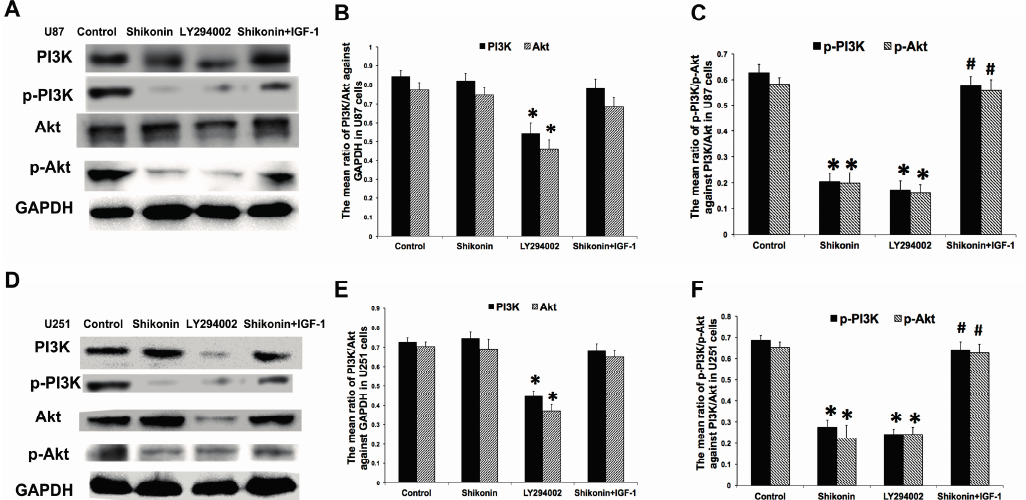
Figure 9. The effects of PI3K/Akt inhibitor or agonist on the expression of p-Akt and p-PI3K in glioma cells. U87 and U251 cell were treated with shikonin (5 μ mol/L), PI3K/Akt inhibitor LY294002 (20 μ mol/L), or shikonin combined with PI3K/Akt agonist IGF-1 (20 μ g/mL). Only LY294002 inhibited the expression of PI3K and Akt in both cell lines compared with the control group. The expression of p-PI3K and p-Akt was inhibited by shikonin or LY294002 compared with the control group and was upregulated by the treatment of IGF-1, indicating that activation of PI3K/Akt could reverse shikonin-induced inhibition on p-PI3K and p-Akt. ( A ) Results of Western blot assay in U87 cells; ( B ) Statistical analysis of PI3K/Akt expression levels in U87 cells; ( C ) Statistical analysis of p-PI3K/p-Akt expression levels in U87 cells; ( D ) Results of Wsestern blot assay in U251 cells; ( E ) Statistical analysis of PI3K/Akt expression levels in U251 cells; ( F ) Statistical analysis of p-PI3K/p-Akt expression levels in U251 cells. * p < 0.05 compared with